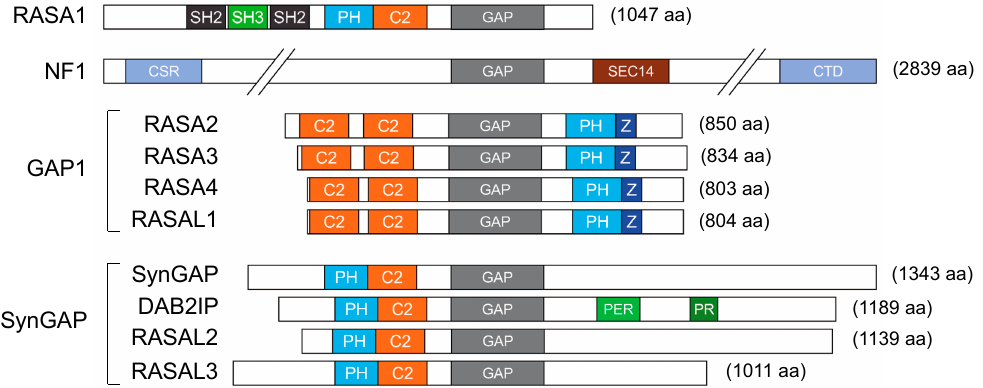
Figure 1. Domain organization of RasGAPs (Ras GTPase-Activating Proteins). In addition to the GAP domain, different RasGAP proteins are characterized by a specific array of functional domains, orchestrating their subcellular localization and regulation (SH2 = Src homology 2 domain; SH3 = Src homology 3 domain; PH = plekstrin homology domain; C2 = calcium-dependent phospholipid-binding motif; CSR = Cys / Ser-richregion; SEC14 = CRAL-TRIOlipid-bindingdomain; CTD = C-terminaldomain; Z = Btk-type zinc finger motif; PER = period-like domain; PR = proline-rich region). Representative proteins are drawn based on UniProtKB entries (2020_05 release, https: // www.uniprot.org / ). Note that NF1 is not drawn to